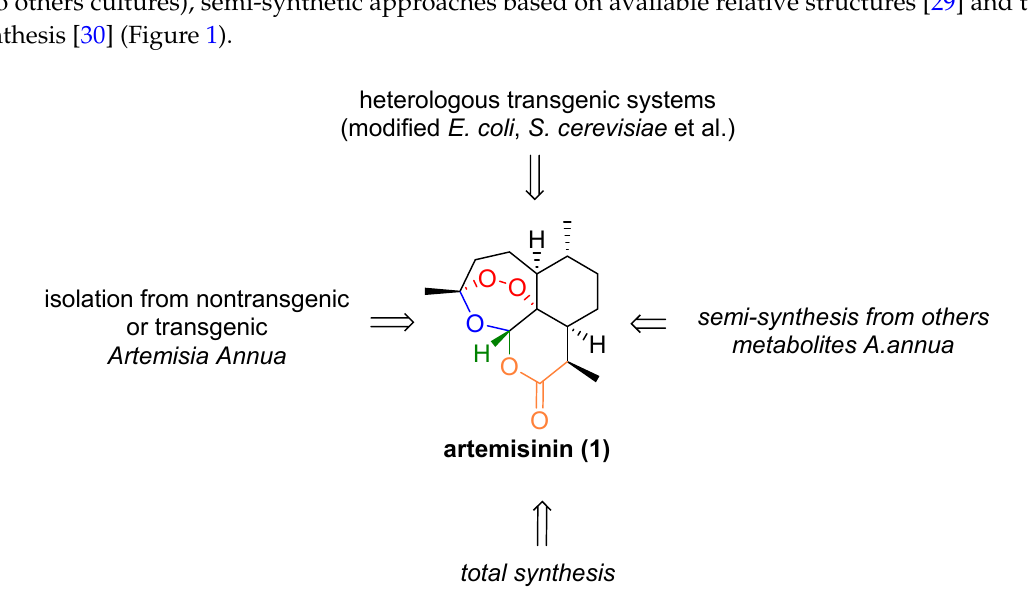
Figure 1. Main strategies for artemisinin production.